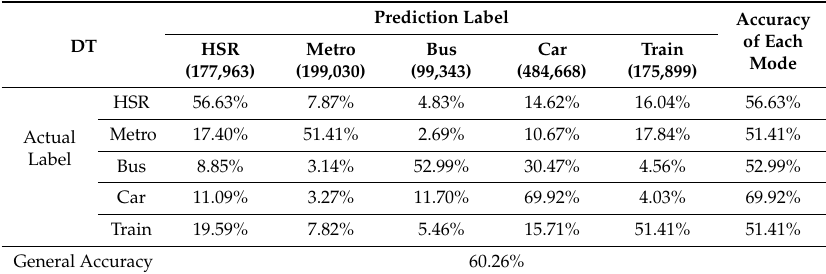
Figure 11. Performance comparison between transportation and vehicle mode classification using three machine learning algorithms. Table 9. Confusion matrix of the decision tree with the proposed features.